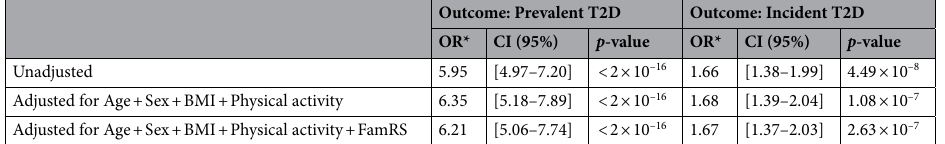
Table 2. Results of Logistic regression models of the effect of PGS on risk of prevalent and incident diabetes. * OR are given for increase in 1 SD of PGS (0.123).